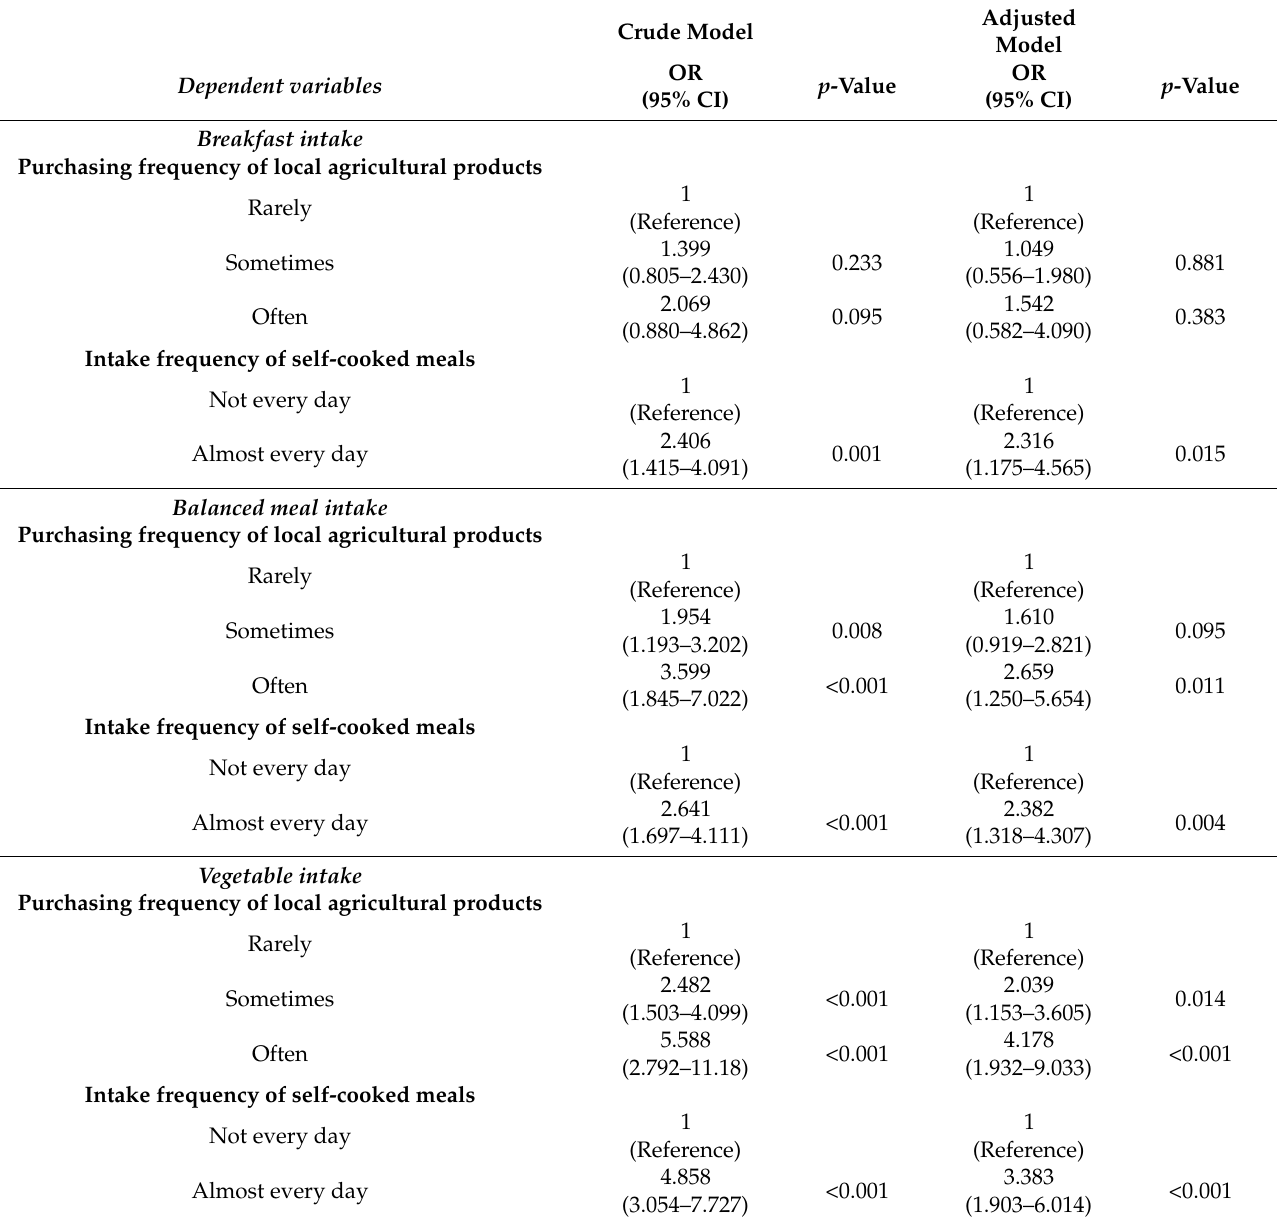
Table 3. Purchasing frequency of local agricultural products, intake frequency of self-cooked meals, and healthy eating habits (logistic regression